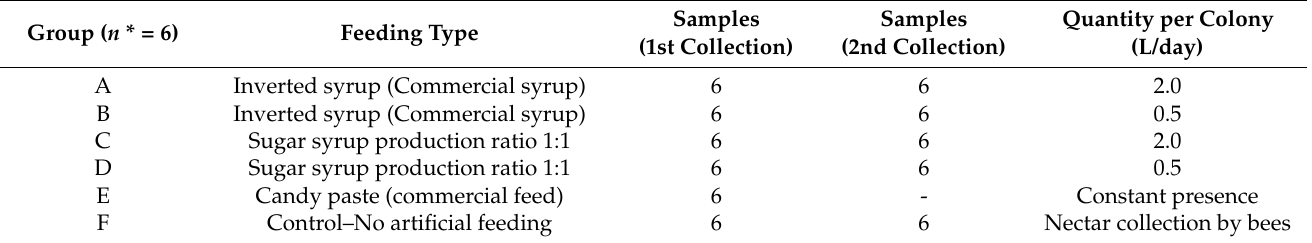
Table 1. Groups, feeding protocols per group and number of samples